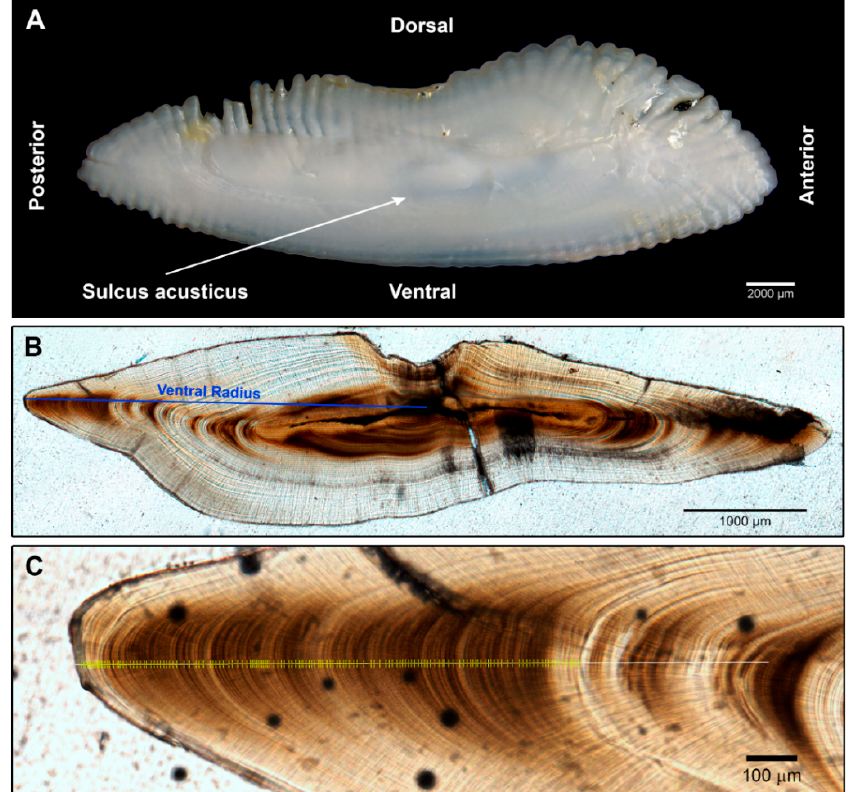
Figure 2. ( A ) Image of European hake right sagittae otolith (5 × of magnification) before its processing. ( B ) Mosaic of the cross-section of right sagittae otolith (20 × of magnification), with the ventral radius (blue line). ( C ) Axis (white line) and marks (yellow crosses) of the ventral lecture of the cross-section of the right otolith (20× magnification).